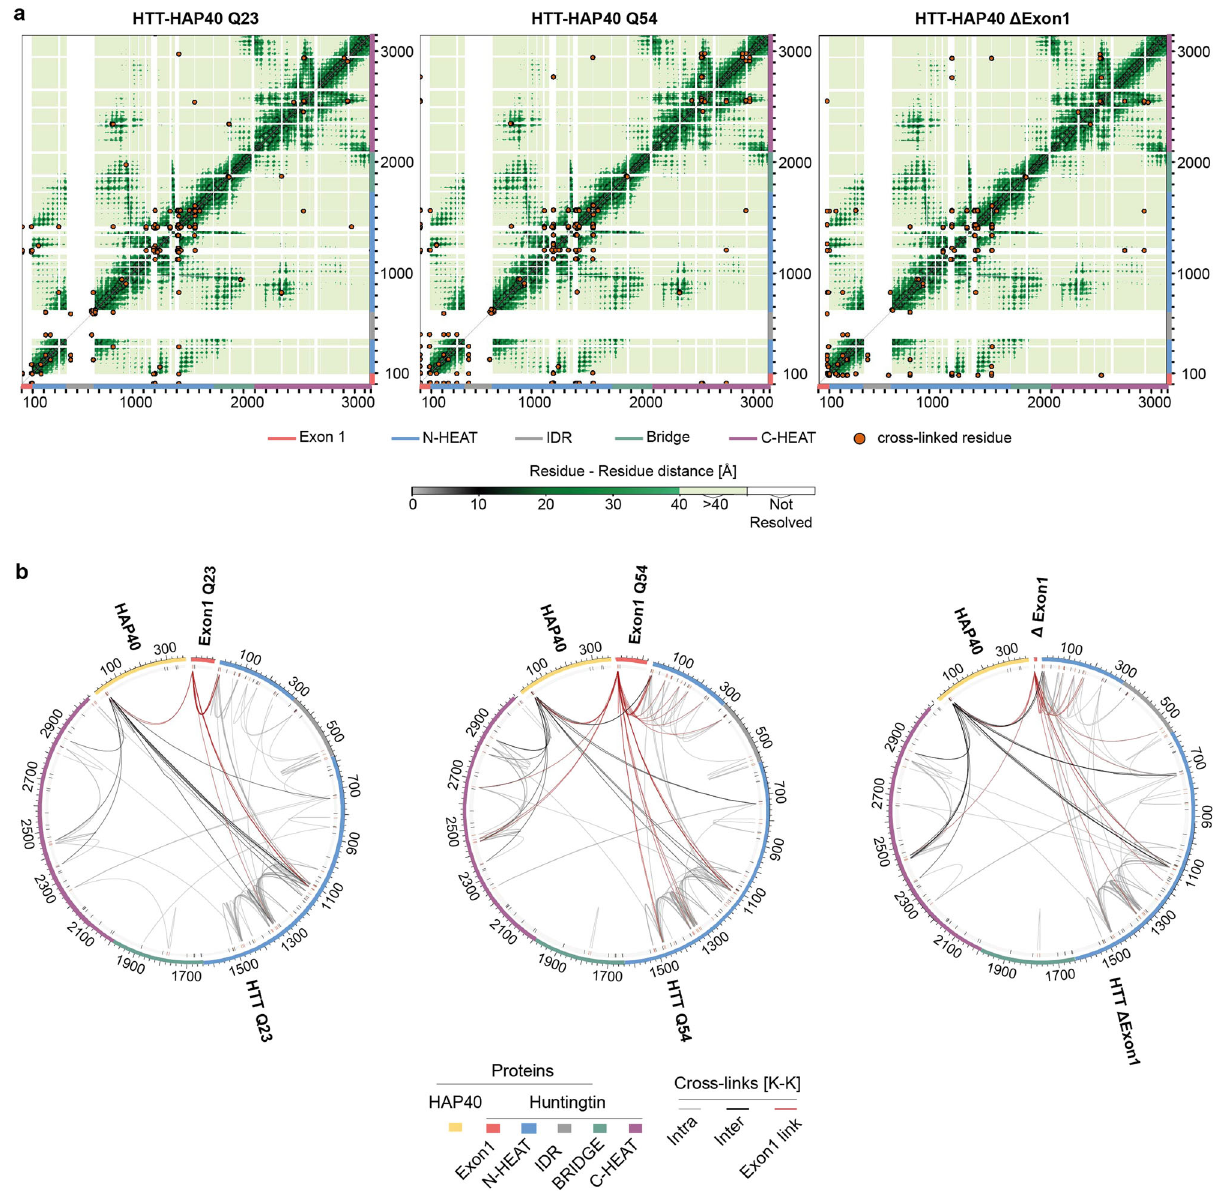
Fig. 5 Exon 1 is highly fl exible and conformationally dynamic in the context of the full-length protein. a Mapping cross-linked sites to the HTT-HAP40 sequence of different samples, with cross-linked residue pairs shown as orange circles. Intramolecular distances for HTT-HAP40 (PDBID: 6X9O) shown from grey to green as per the coloured scale bar with unmodelled regions of the protein shown in white. b Mapping cross-links to the HTT-HAP40 sequence of different samples, with exon 1 in red, N-HEAT in blue, bridge domain in green, IDR in grey, C-HEAT in purple and HAP40 in yellow. Cross- linked lysine residues are indicated in red and unmodi fi ed lysine residues are indicated in black on the numbered sequence. Intermolecular cross-links (HTT-HAP40) are shown in black, intramolecular cross-links (HAP40-HAP40 or HTT-HTT) are shown in grey and exon 1 cross-links are shown in red. All residues following the exon 1 region of the different constructs are numbered the same for